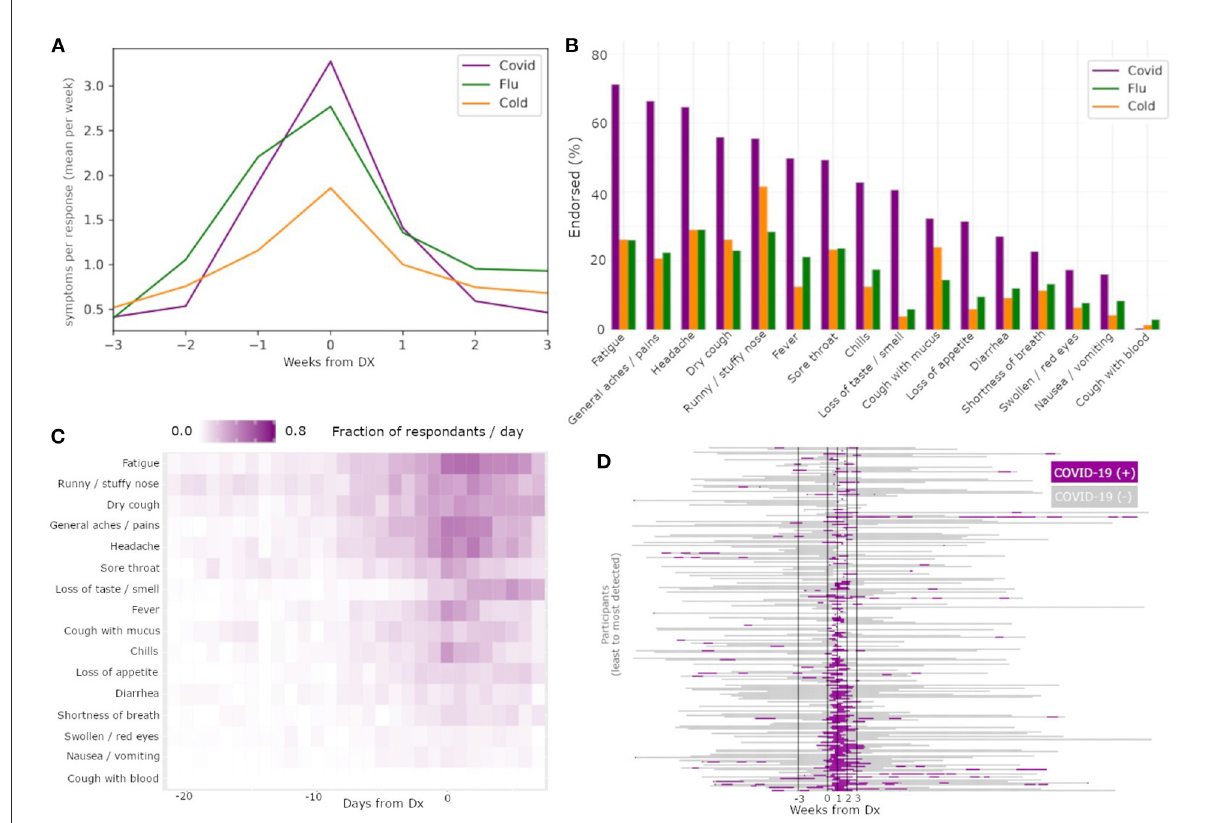
FIGURE2 Differences among illnesses and across symptoms enable COVID-19 specific classification. The mean symptom rate for individuals with a diagnosis date reported for COVID-19 (yellow), flu (green), and cold (purple) (A) . Percent of individuals with these diagnoses reporting each of the recorded symptoms, by illness type, sorted by prevalence within COVID-19 subjects (B) . Heatmap of symptom report frequency by days from diagnosis (C) reveal different temporal profiles and likelihood across symptoms within reports paired to COVID-19 diagnoses. Results from a Bayesian classifier network (D) run on all times with symptom reports reveal good alignment between positive detections (green) and diagnosis date.